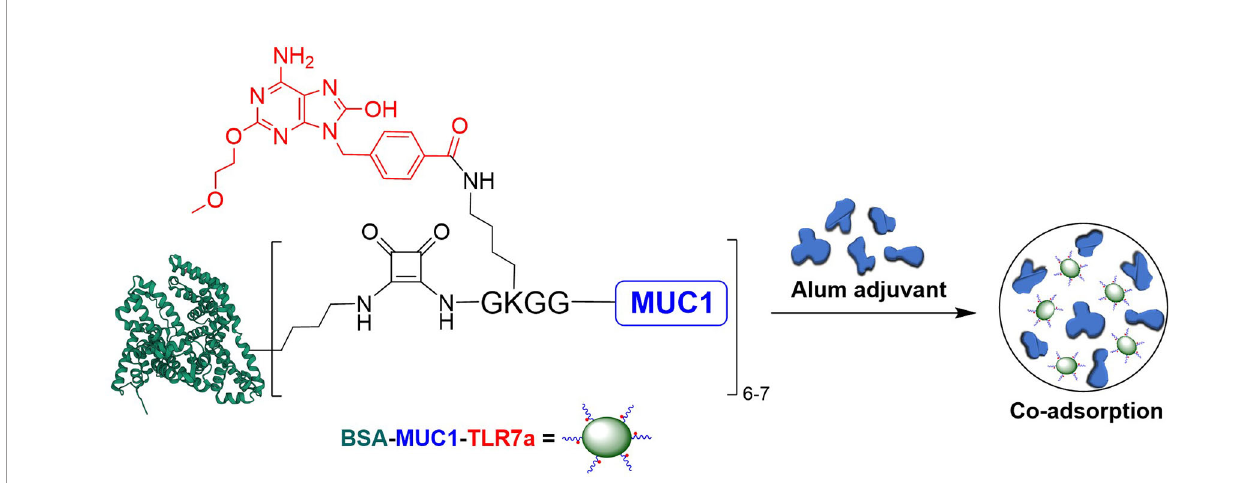
FIGURE 1 | Design of the three-component conjugate (BSA-MUC1-TLR7a) and its co-adsorption with Alum adjuvant (PDB code of BSA: